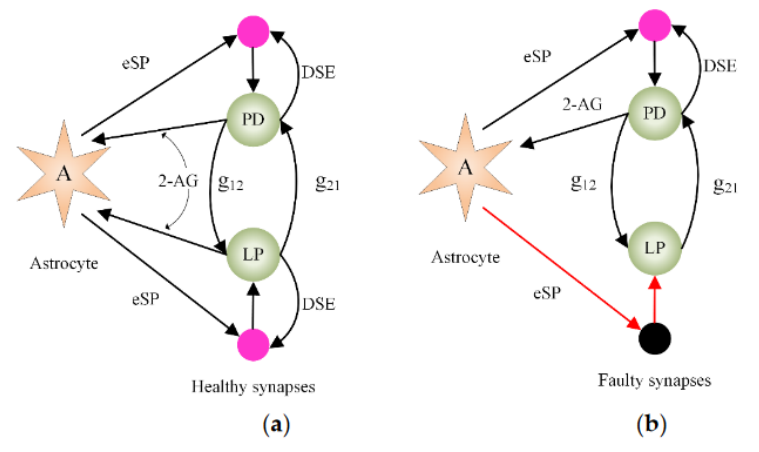
Figure 2. The BiSRP ‐ CPG model. ( a ) Healthy network; ( b ) Faulty network. Figure 2. The BiSRP-CPG model. ( a ) Healthy network; ( b ) Faulty